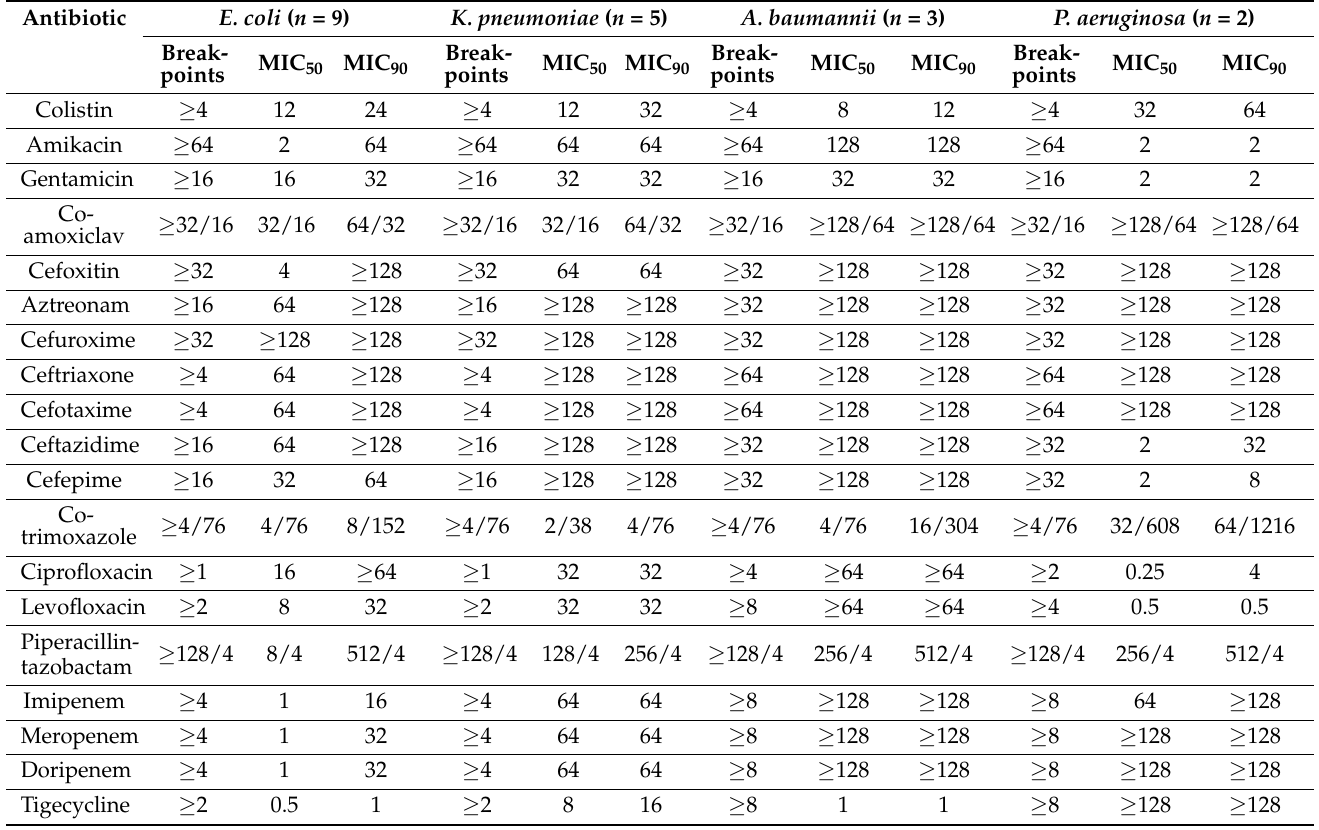
Table 4. Comparison of the MIC 50 and MIC 90 ( µ g/mL) values among the bacterial strains harboring mcr genes.